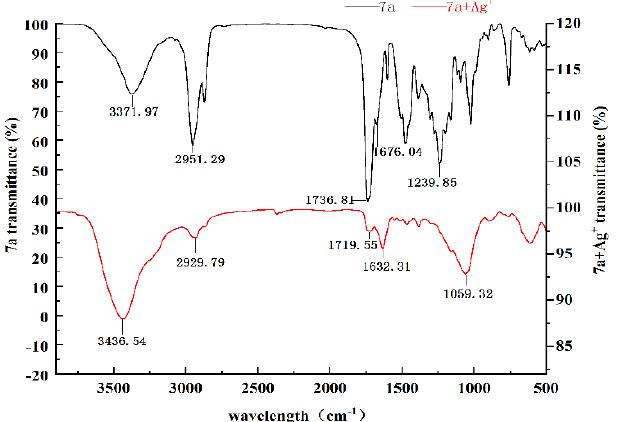
Figure 5. Infrared absorption spectra of compound 7a and complex compound 7a + Ag + .